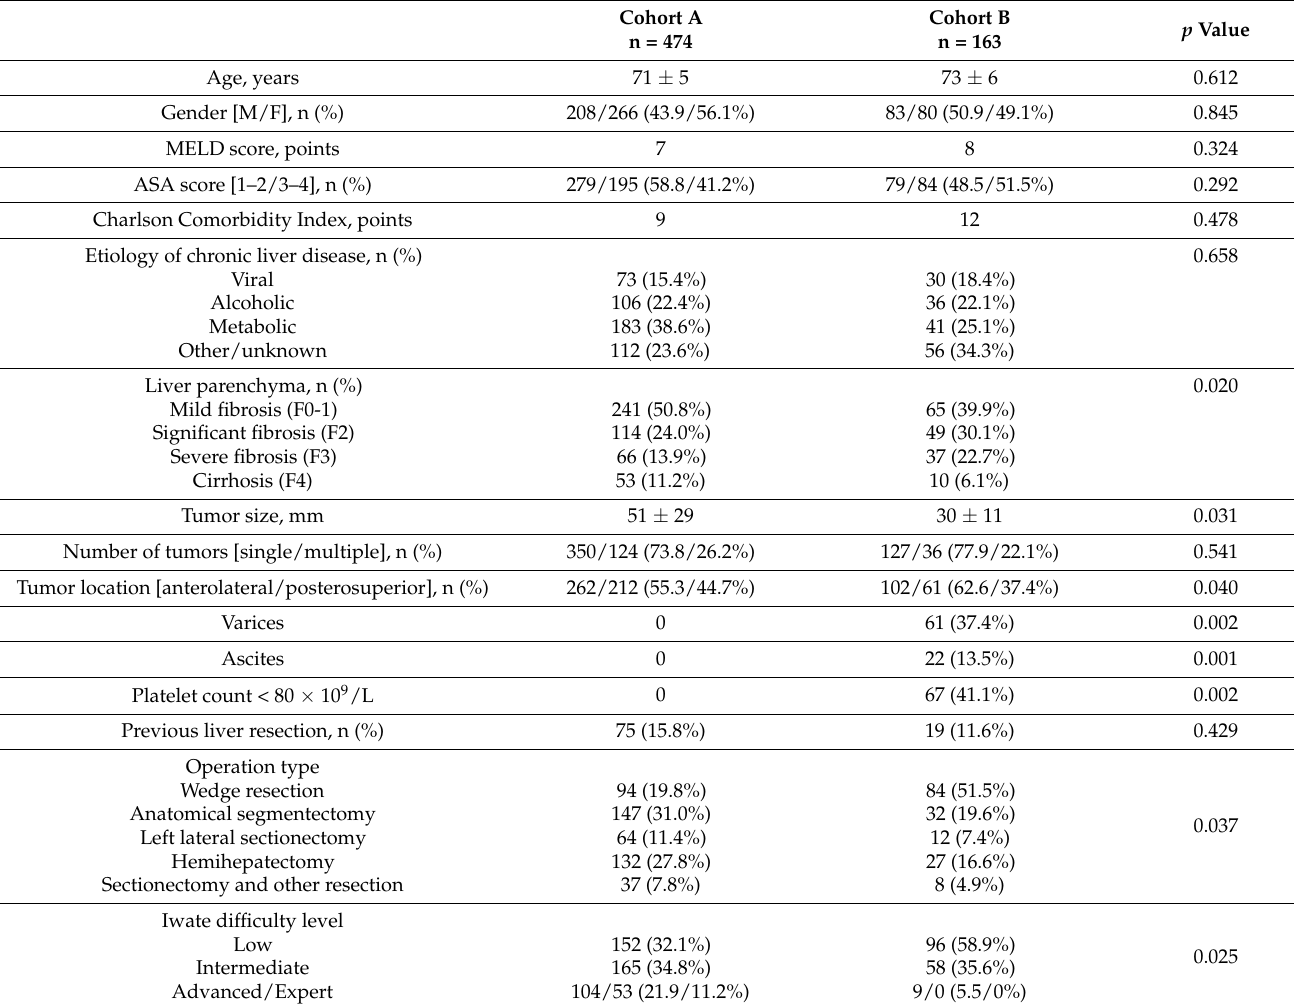
Table 1. Baselines of MILRs for HCC in Child A and in advanced cirrhosis (Child B and Child A/B with portal hypertension)